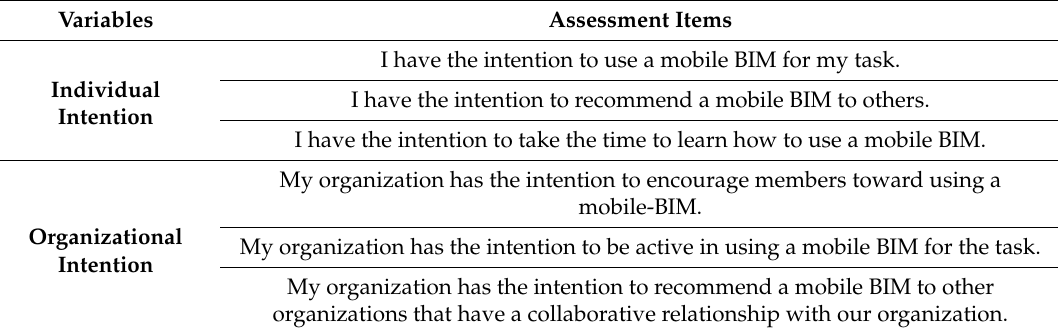
Table 7. Assessment items of individual and organizational intention to accept a mobile